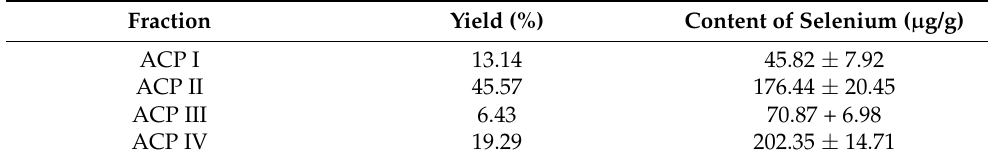
Table 4. Yield and content of polysaccharides and selenium of ACP I, ACP II, ACP III, and ACP IV.